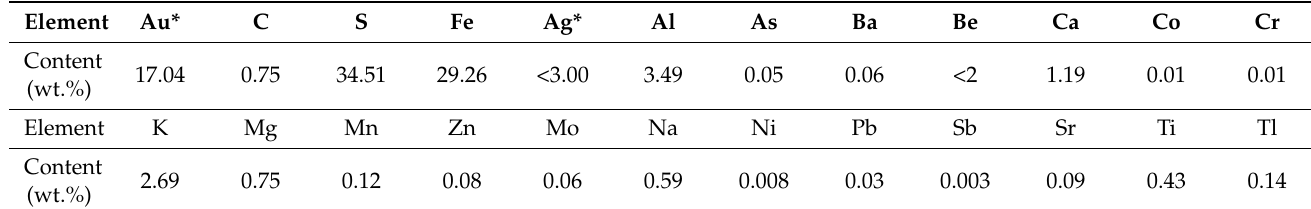
Table 1. Chemical analysis of the concentrated and screened sulfide gold sample < 45 µ m (Au*, Ag*: ppm).